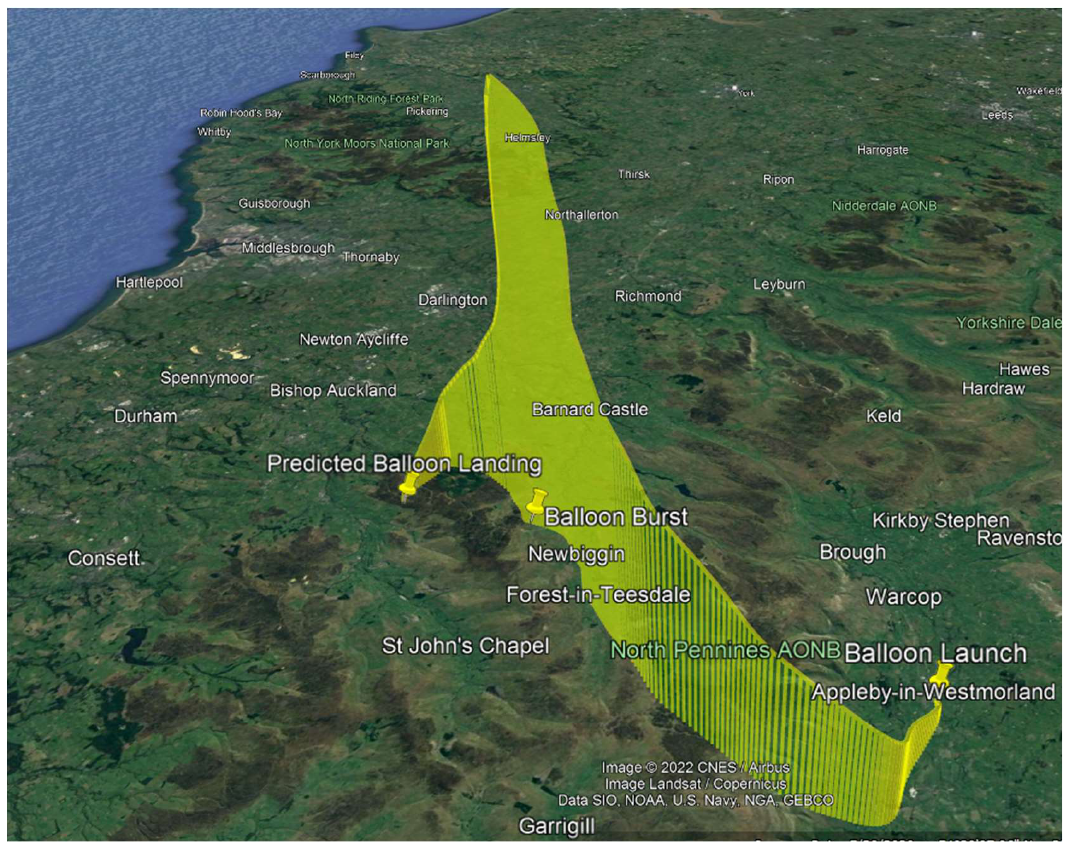
Figure 29. Three-dimensional presentation of predicted flight trajectory.